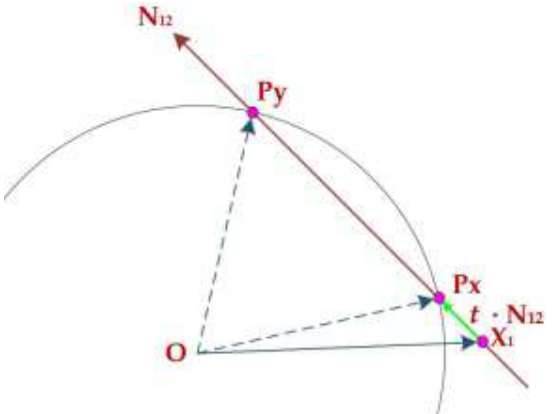
Figure 6. Section by the plane containing vector X 1 , points Px and Py, direction vector ( N 12 ), and t. If point Px is obtained, then transforming the Cartesian coordinates into spherical